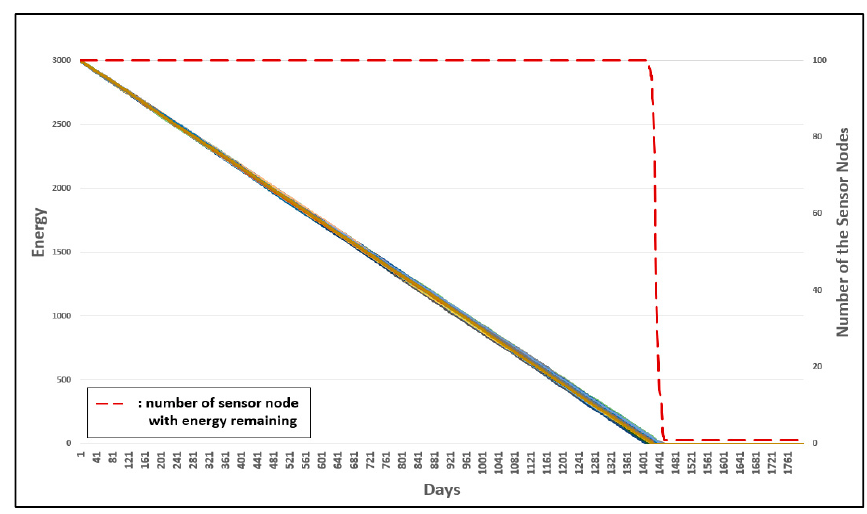
Figure 24. Energy consumption of 3-D GM-MAC using advanced group number management and entire group number resetting.